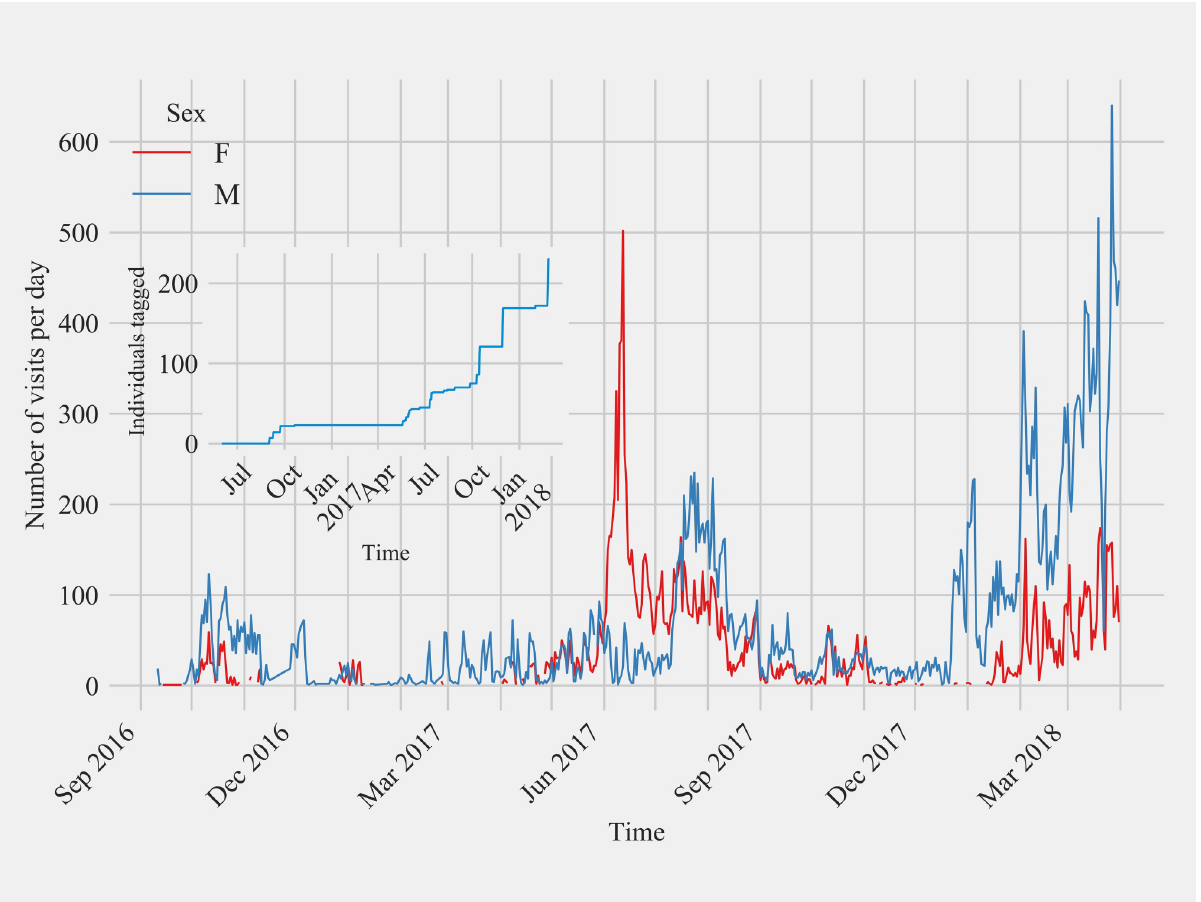
Fig 5. Comparison of the daily detections from the two different antennas at the double antenna feeding station transceiver at Site 2 over time. The top antenna for this feeding station was deployed in May 2017 and discontinued in January 2018 for data collection. Overall, the total number of visits detected by the side antenna exceeded the number of visits for the top antenna but not enough to warrant the addition of a second antenna. Both antennas detected the presence of the same number of individual birds.